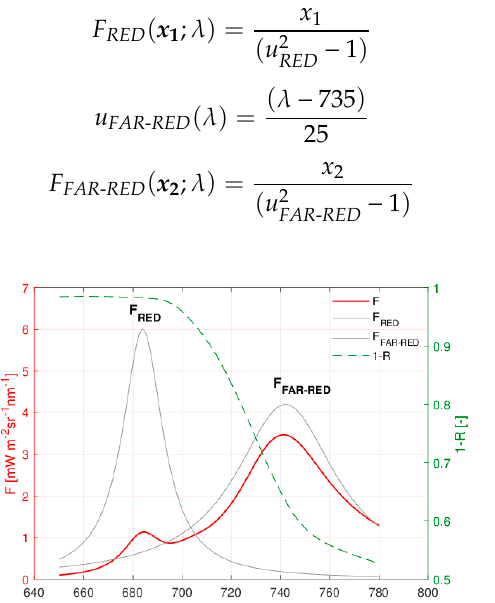
Figure 3. Red and far-red F emission peaks initially modeled by the retrieval algorithm ( gray peaks ); 1- R correction function ( dashed green line ); resulting F spectrum ( red line ).